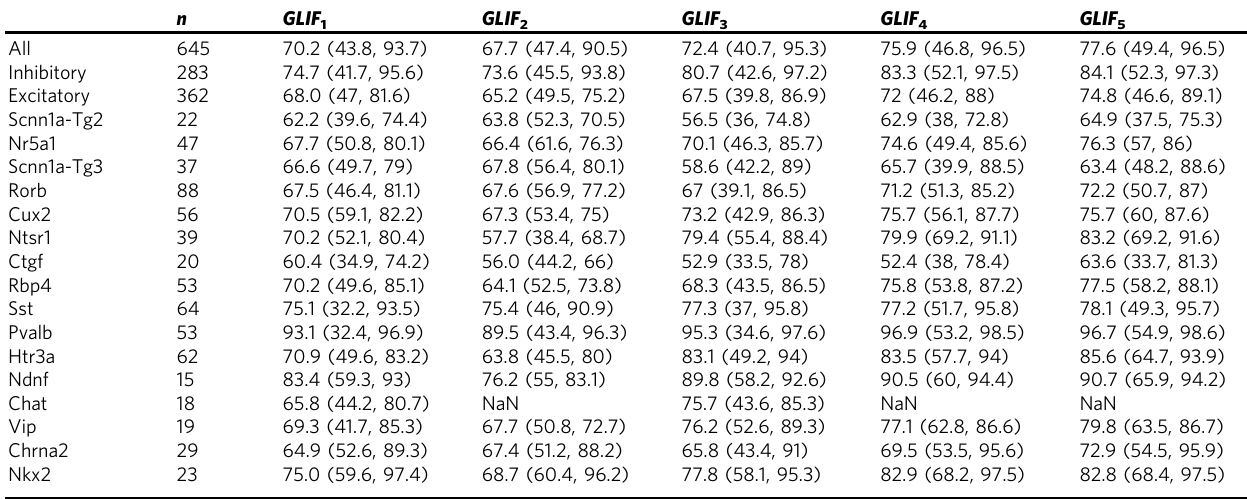
Table 3 Explained variance of all model levels after post hoc